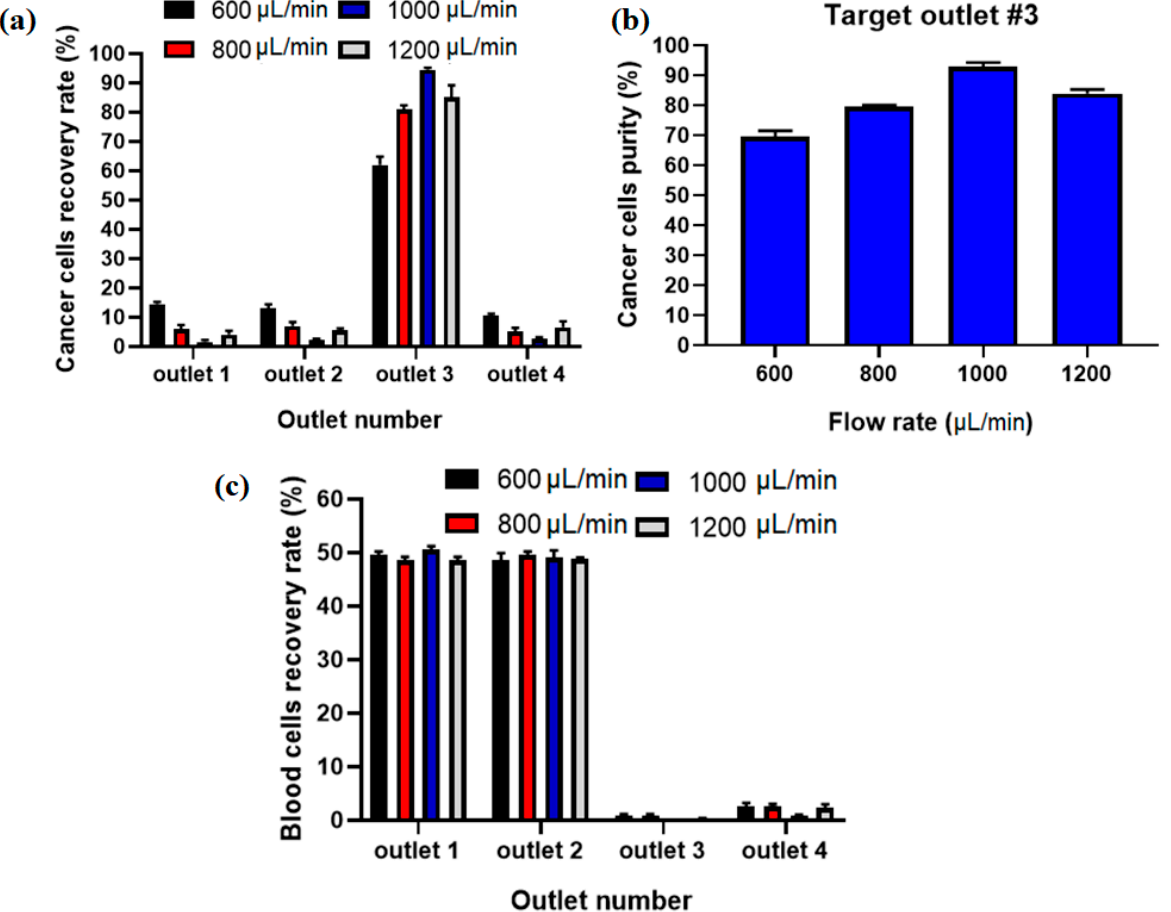
Figure 6. ( a ) Separation efficiency for CTCs at different inlet flow rates. ( b ) Purity of separated CTCs at different flow rates in outlet 3. ( c ) Recovery rate for blood cells at different flow rates and outlets .